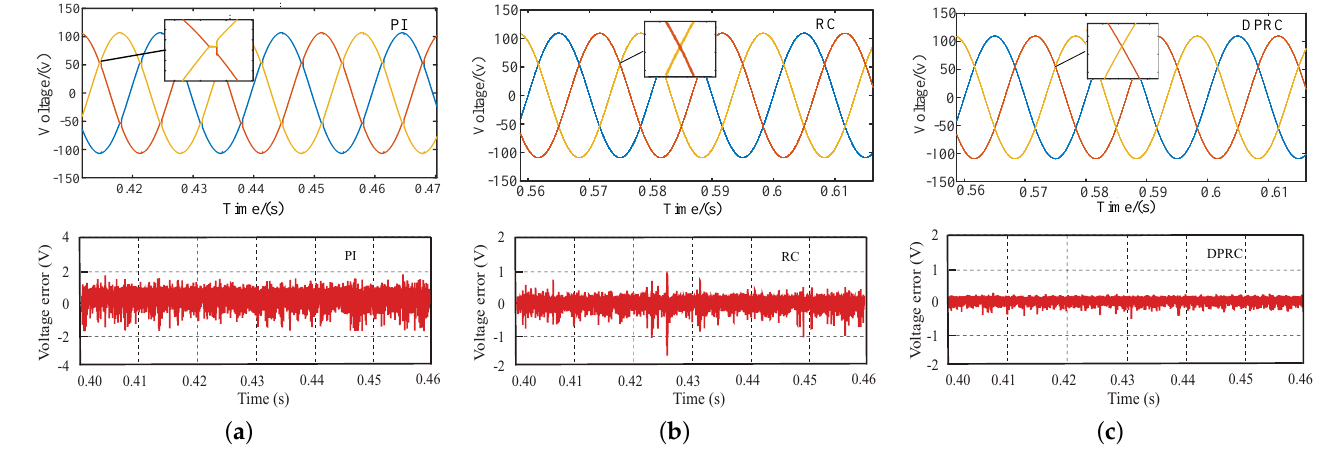
Figure 12. PCC output voltage and d-axis voltage error. ( a ) PI controller ( b ) RC controller ( c ) DPRC controller.